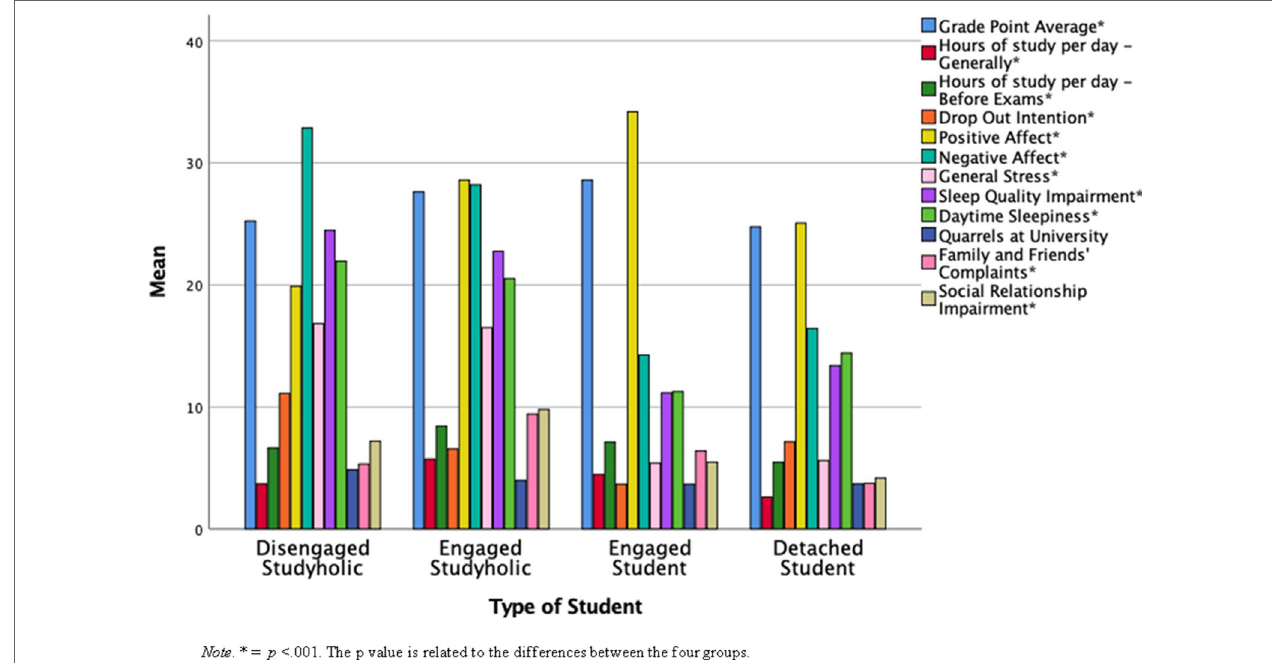
FIGURE 5 | Bar graphs representing the mean of the outcomes by the four groups of